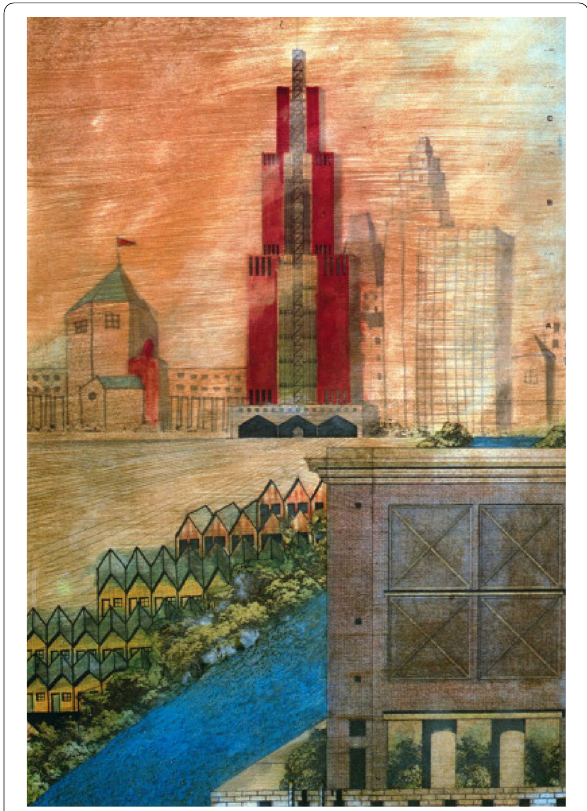
Fig. 14 Aldo Rossi, The Tower of Memories, A Landmark